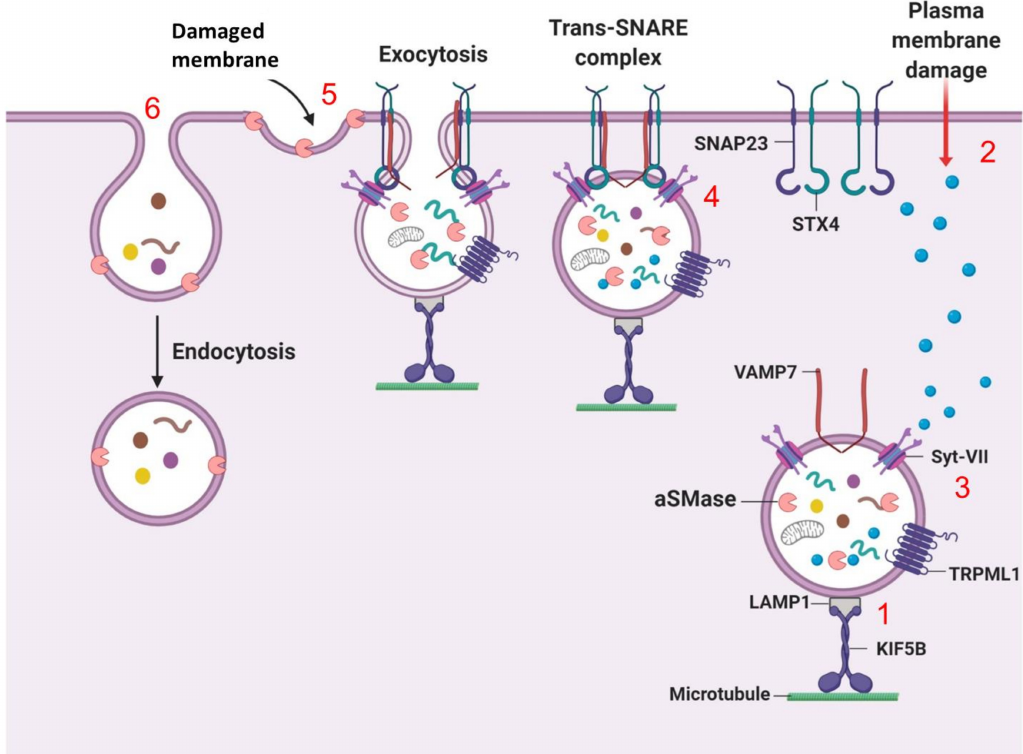
Figure 4. Lysosome exocytosis-dependent plasma membrane repair. Upon damage to the PM, (1) lysosomes are translocated to the cell periphery via cytoskeleton and motor protein, Kinesin 5 subfamily member KIF5B, which is bound to LAMP1 on the lysosomal membrane. (2) Injury to the PM can lead to an influx of Ca 2 + in cells, which is then (3) sensed by Ca 2 + sensor, Syt-VII (synaptotagmin-VII) on the lysosomal membrane and triggers a repair mechanism. (4) Subsequently, exocytosis is initiated by the lysosomal membrane localized VAMP7 (vesicle-associated membrane protein 7) that forms a Trans-SNARE complex with syntaxin-4 and SNAP23 (synaptosome-associated protein 23 kDa) on the PM. Trans-SNARE complex brings the lysosome in a close proximity to the PM to initiate the fusion of lysosome and PM. (5) The fusion of lysosome and PM triggers an e ffl ux of lysosomal enzyme aSMase (sphingomyelinase), which is then retain on the PM to convert sphingomyelin into ceramide, (6) leading to an inward configuration of the PM to facilitate endocytosis-dependent removal and restoration of damaged